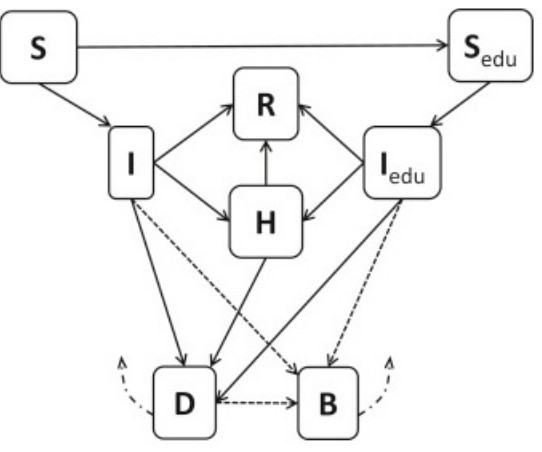
Fig. 7 Transfer diagram for the Ebola compartment model including education as a preventive measure